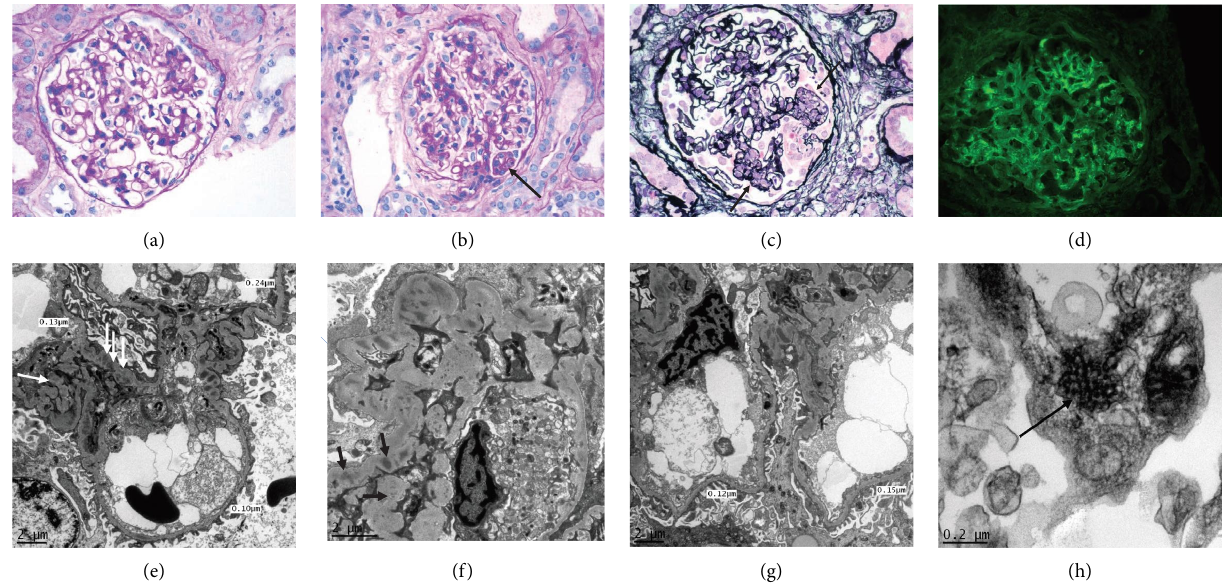
Figure 3: (a) Second biopsy: a glomerulus with no evidence of hypercellularity (PAS; × 400). (b) Second biopsy: a glomerulus with mild endocapillary proliferation (arrow) (PAS; × 400). (c) Secondary biopsy: a glomerulus with endocapillary proliferation in two segments (arrows) and, GBM breaks and crescent formation between the two segments (PAMS; × 400). (d) Secondary biopsy: deposition of granular immune complexes along the GBM and, to a lesser degree, within the mesangium (IF, IgG; × 400). (e) Second biopsy: thin GBM, intramembranous and para-mesangial electron dense deposits (arrows), and focal efacement of foot processes (EM; scale bar � 2 μ ). (f) Second biopsy: intramembranous and mesangial electron dense deposits (arrows), and efacement of foot processes (EM; scale bar � 2 μ ). (g) Second biopsy: thin GBM, intramembranous and para-mesangial electron dense deposits, endothelial cell swelling and loss of fenestration (EM; scale bar � 2 μ ). (h) Tubulo-reticular inclusions within the endothelial cytoplasm (EM; scale bar � 22 μ ).